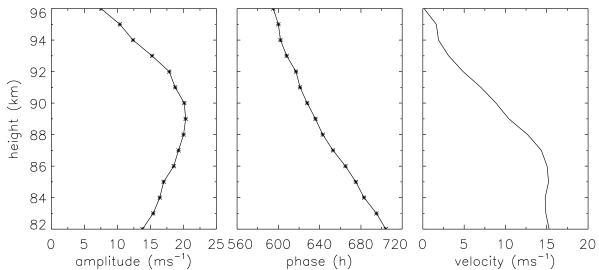
Figure 2. Left: amplitude of oscillation in zonal wind at 82–96km over Maui. Middle: phase of oscillation. Right: averaged zonal wind. The asterisks represent the fitted values.